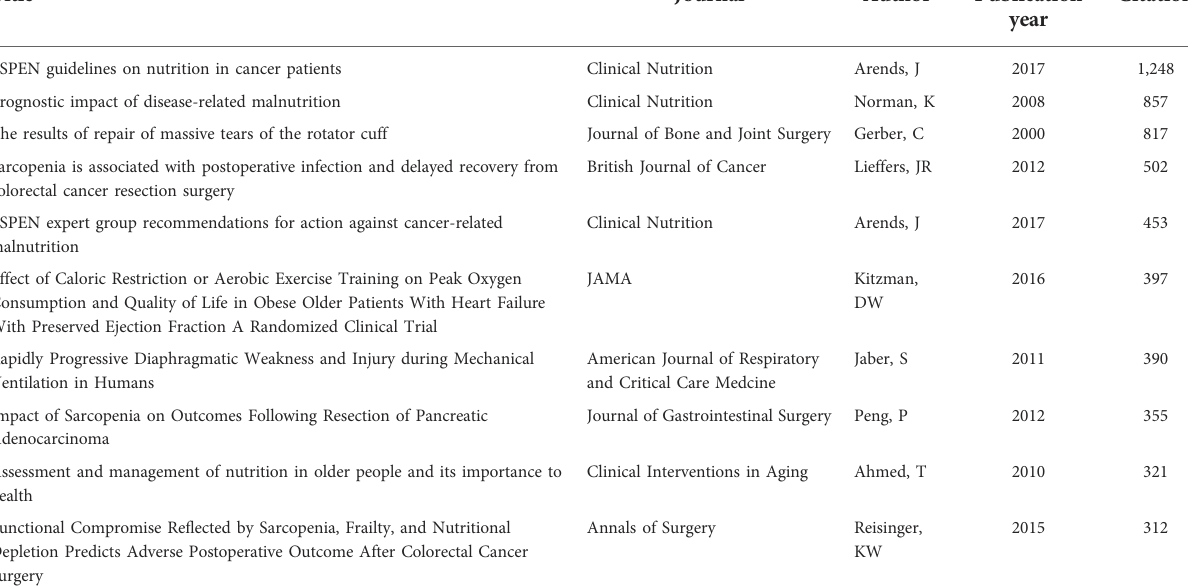
TABLE 6 The top 10 studies with the most citations on the relationship between sarcopenia and